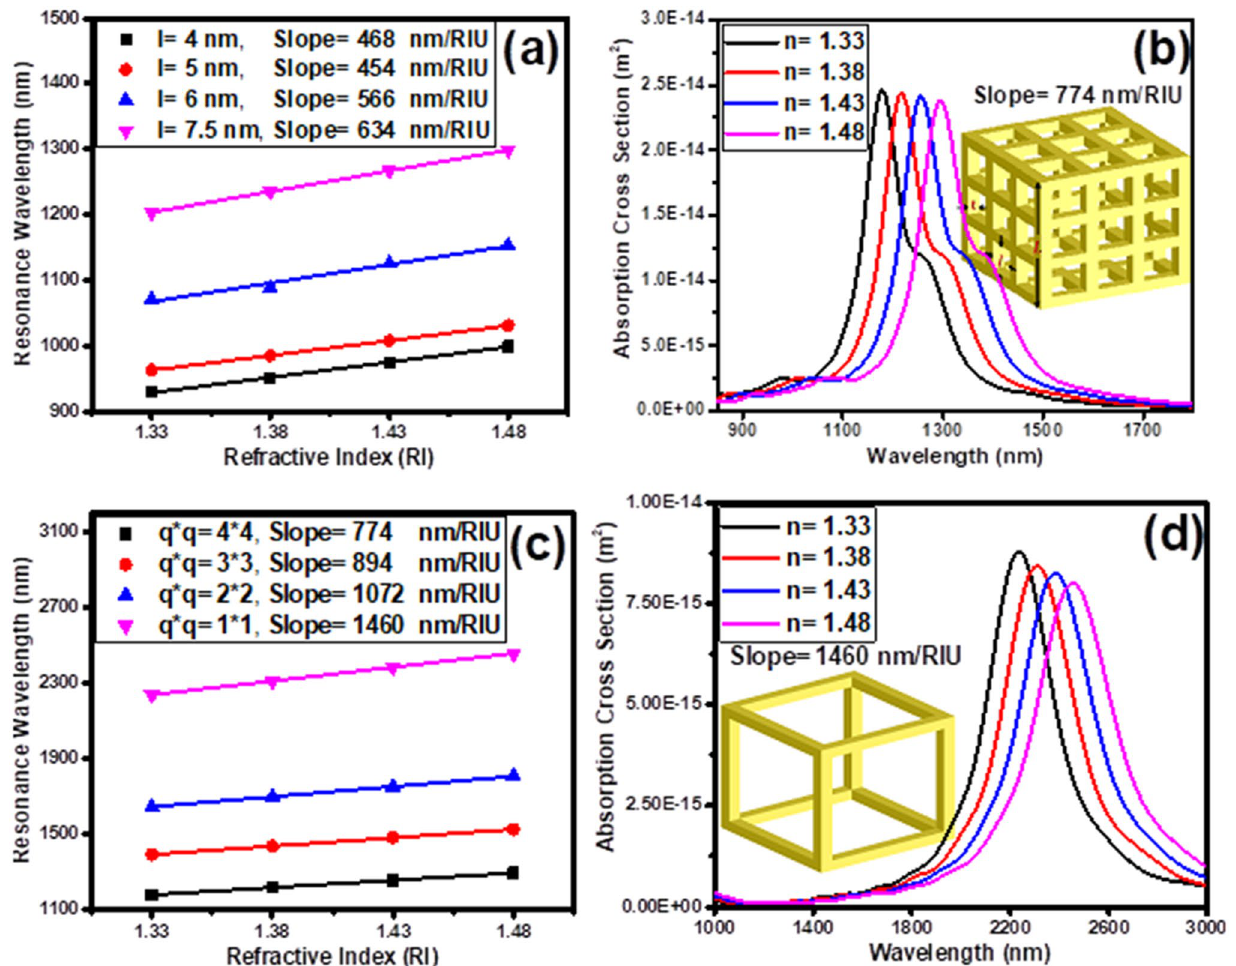
Figure 2. ( a ) Resonance wavelength shift of core-texture shell SiO 2 @Au nanocages versus refractive index of surrounding medium for different etch lengths, l (cavities array are 4*4). ( b ) Absorption cross section of etched core-texture shell optimized cubic nanocage ( T = 4 nm and l = 7.5 nm (g = 4 nm)) versus refractive index of surrounding medium. ( c ) Resonance wavelength shift of etched core-texture shell versus different refractive index of surrounding medium for different number of cavities array ( d ) Absorption cross section of optimum cubic nanocage (nanoframe) versus refractive index of surrounding medium. Browser-based version of SketchUp, https ://app.sketc hup.com, and Origin 2020 version, https ://www.origi nlab.com, have been used for drawing images and making figures,